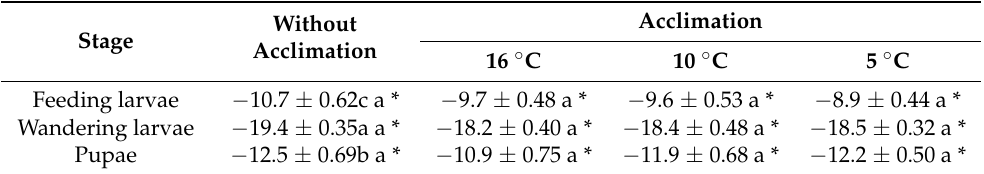
Table 1. Stage-specific supercooling points of SHB ( ± standard error) with acclimation and without